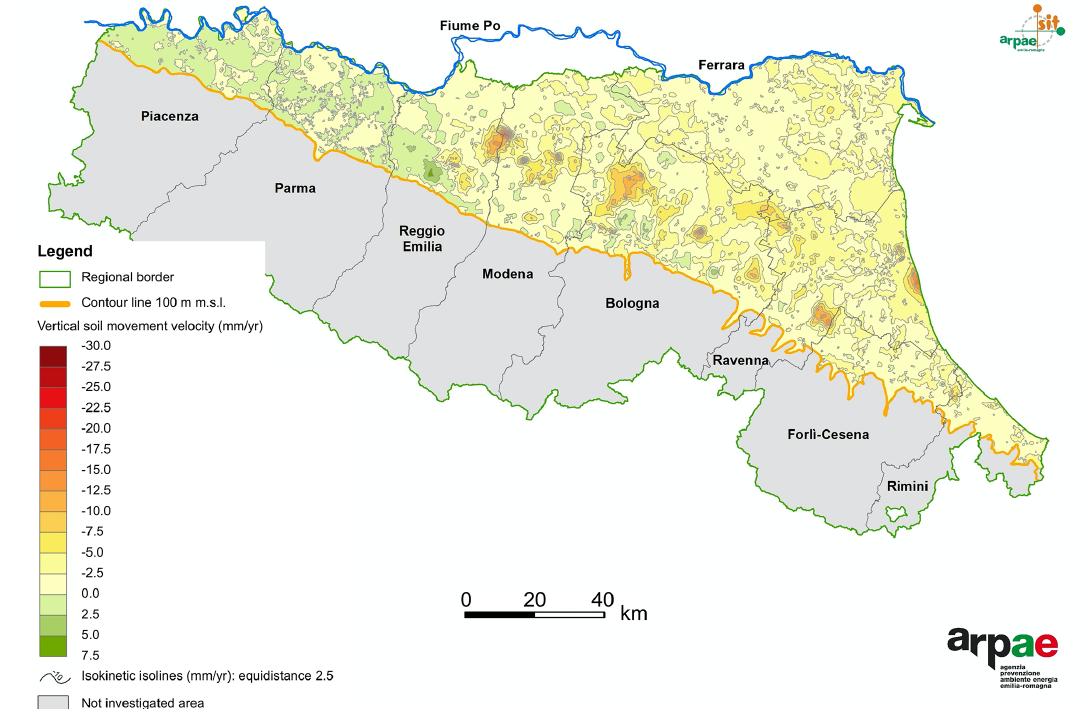
Figure 6. Updated subsidence map of Emilia-Romagna region with isokinetic